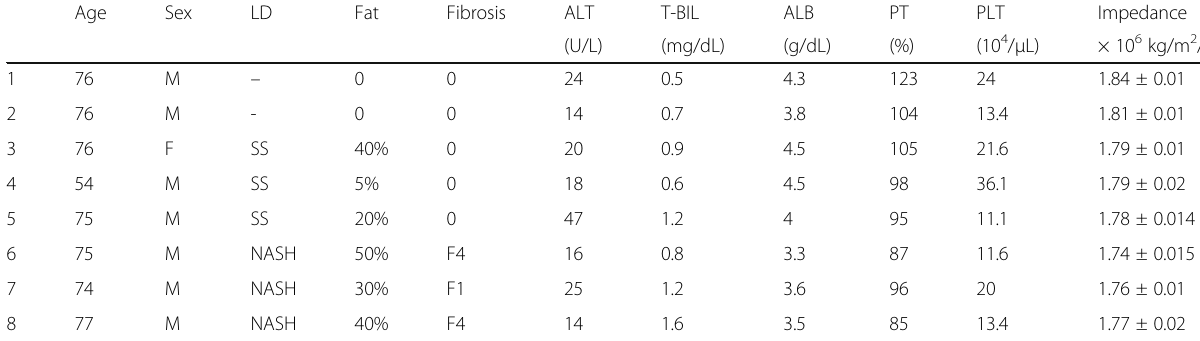
Table 4 Characteristics of human subjects